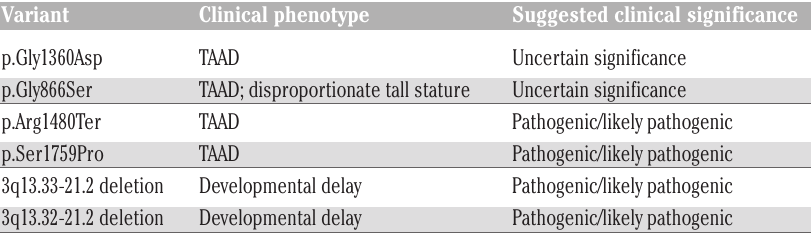
Table 1. Germline variants in MYLK reported in